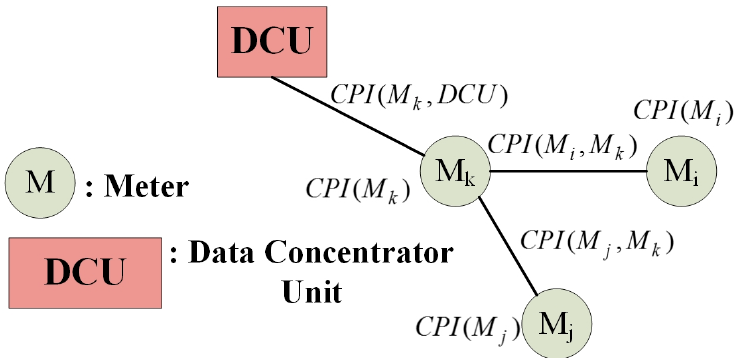
Figure 6. Part of Communication Network under DCU.